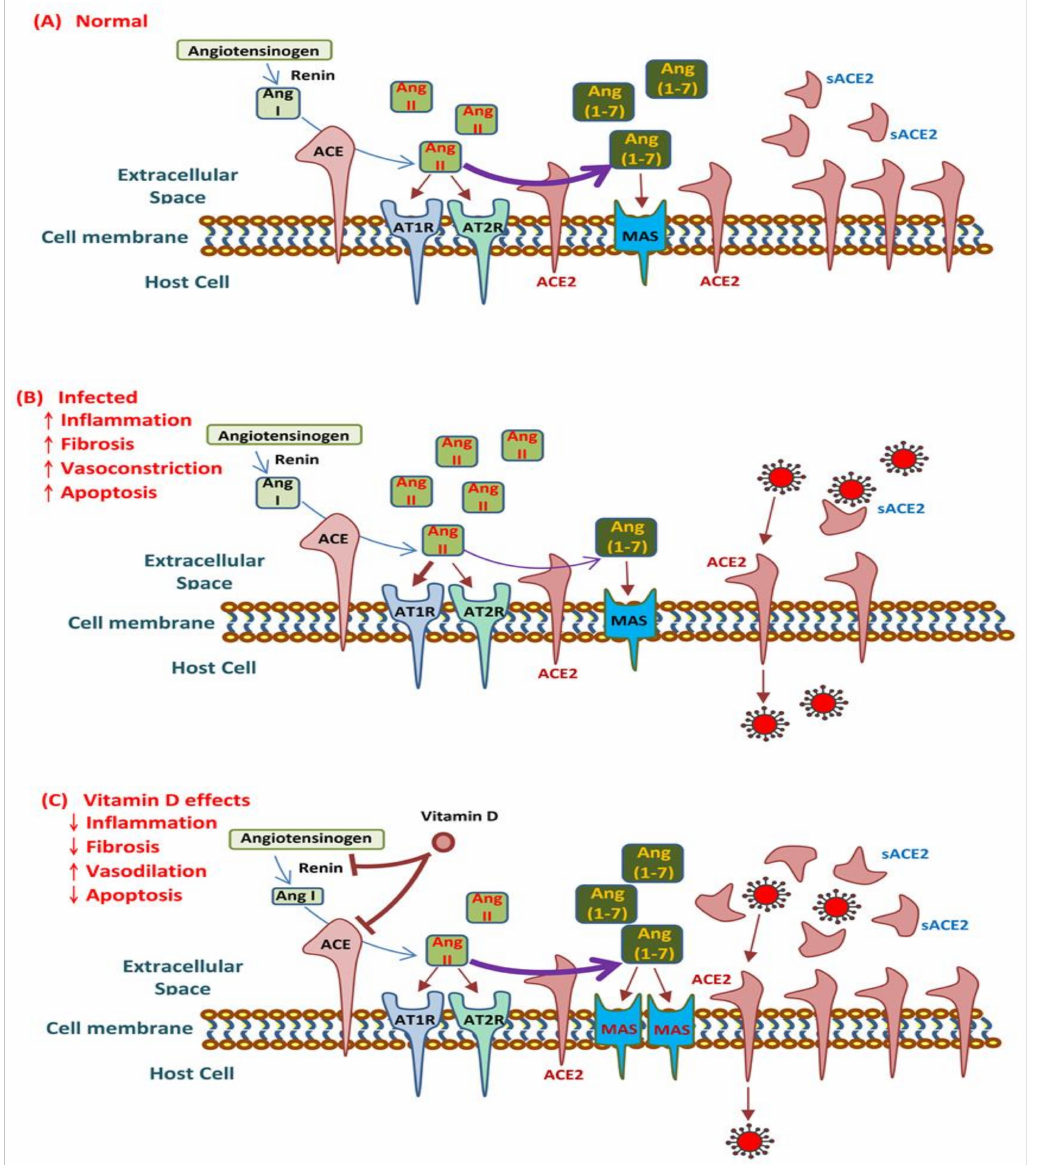
Figure 4. Effects of vitamin D on angiotensin-converting enzyme 2 (ACE2) and the renin–angiotensin–aldosterone system (RAS) in response to the coronavirus disease 2019 (COVID-19). ( A ) Schematic of the RAS under normal circumstances, with physiological steps of the generation of angiotensin (Ang) II and Ang 1–7 shown, as well as their activity on specific receptors. ( B ) Interaction of the severe acute respiratory syndrome coronavirus 2 with the RAS. ( C ) Possible therapeutic effects of vitamin D for COVID-19 and related acute respiratory distress syndrome or macrophage activation syndrome. The ACE2 molecule, besides being a receptor of SARS-CoV-2, reduces the activity of the renin–angiotensin system by converting Ang I and Ang II into Ang 1–9 and Ang 1–7 respectively [33]. Thus, the ACE2 protein has been shown to play an important role in protecting against some disorders such as cardiovascular complications, chronic obstructive pulmonary disease (COPD) and diabetes, among other COVID-19 comorbidities [34]. The ACE2/Ang 1–7 axis counterbalances the ACE/Ang II-I axis by decreasing Ang II levels, the activation of angiotensin type 1 receptors (AT1Rs) and, thus, leads to decreased pathophysiological effects on tissues, such as inflammation and fibrosis